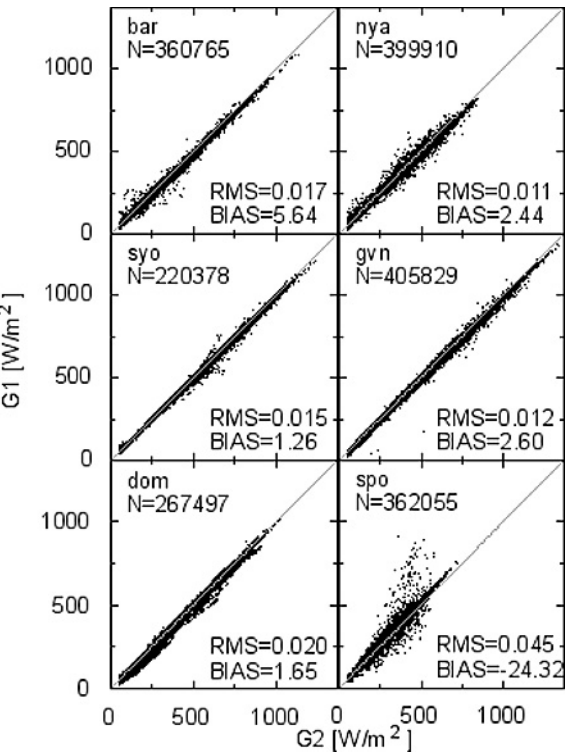
Figure 4. (Left) Comparison between the global radiation mea- sured by the pyranometer (G2) and the sum of direct and di ff use radiation (G1). The cloud of points for spo that stay away from the bisector, originate from a hundred points on 1 January 2009.